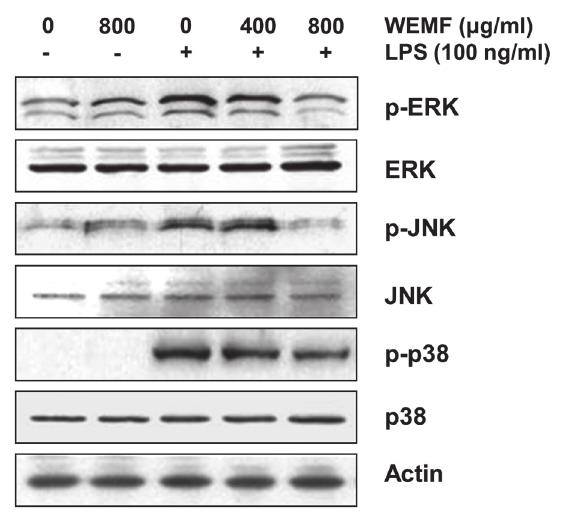
Figure 5 - Effects of WEMF on the LPS-induced phosphorylation of MAPKs in RAW 264.7 macrophages. The cells were treated with the indicated concentrations of WEMF for 1 h prior to treatment with 100 ng/ml LPS for 30 min. Total proteins were isolated and subjected to SDS-polyacrylamide gels, followed by Western blot analysis using the indicated antibodies. Proteins were visualized using the ECL detection